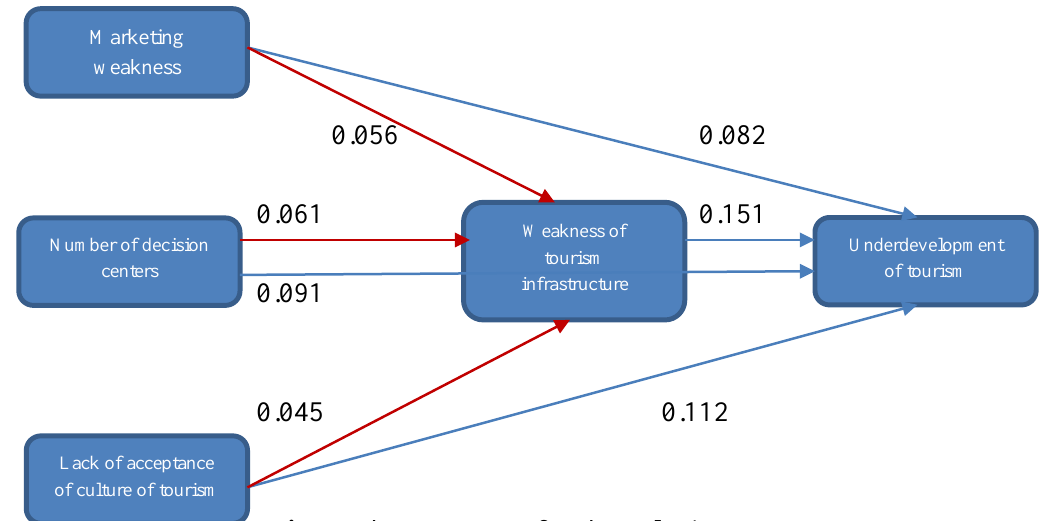
Fig. 5. The structure of path analysis